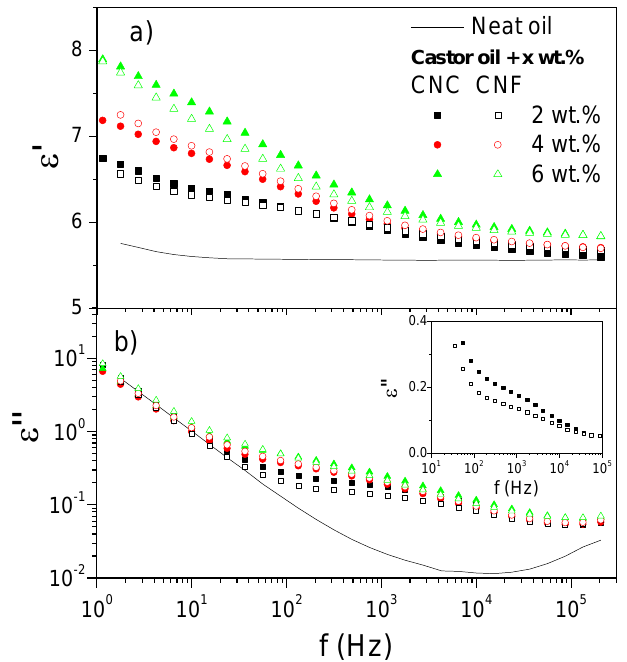
Figure 1. Frequency dependence of ( a ) the dielectric constant, ε´, and ( b ) the dielectric loss, ε´´, at 25 °C for cellulose nanocrystals and cellulose nanofibrils dispersions in castor oil, as a function of cellulose concentration. (Inset: 2 wt.% dispersions with Y -axis in linear scale). Conversely, the two selected nanoclays demonstrated completely different dielectric behaviors.